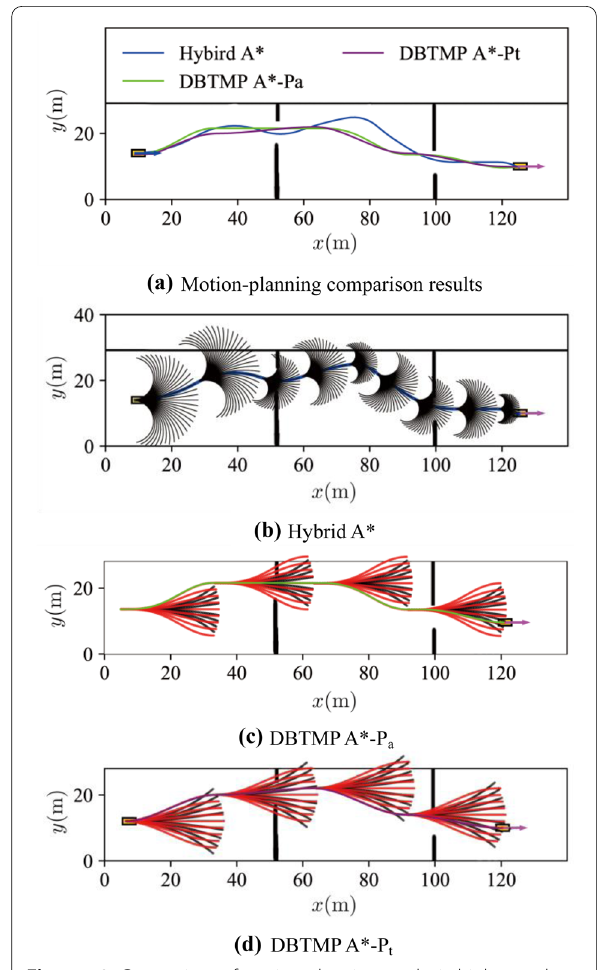
Figure 12 Comparison of motion-planning results in high-speed scenes